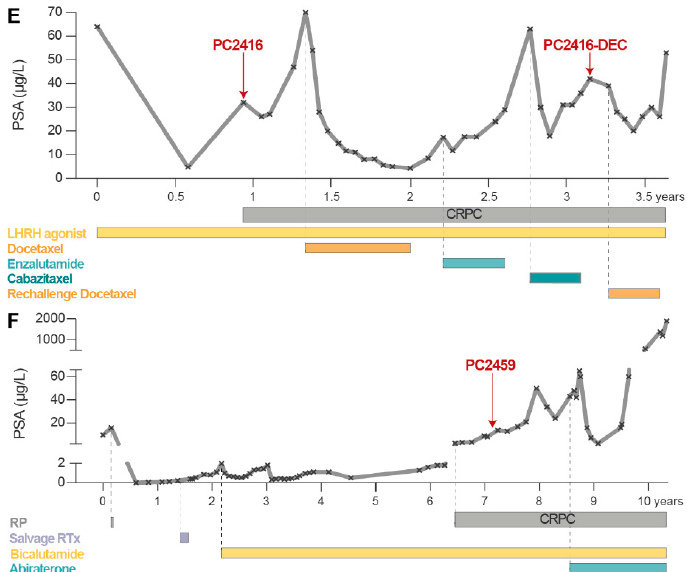
Figure 1. Development of CRPC PDXs. ( A ) Pie chart of PCa samples subcutaneously implanted in intact male nude mice to generate PDXs. No take (yellow) indicates absence of tumor outgrowth during a monitoring period of six months. Tumors take (green) represents successful engraftment